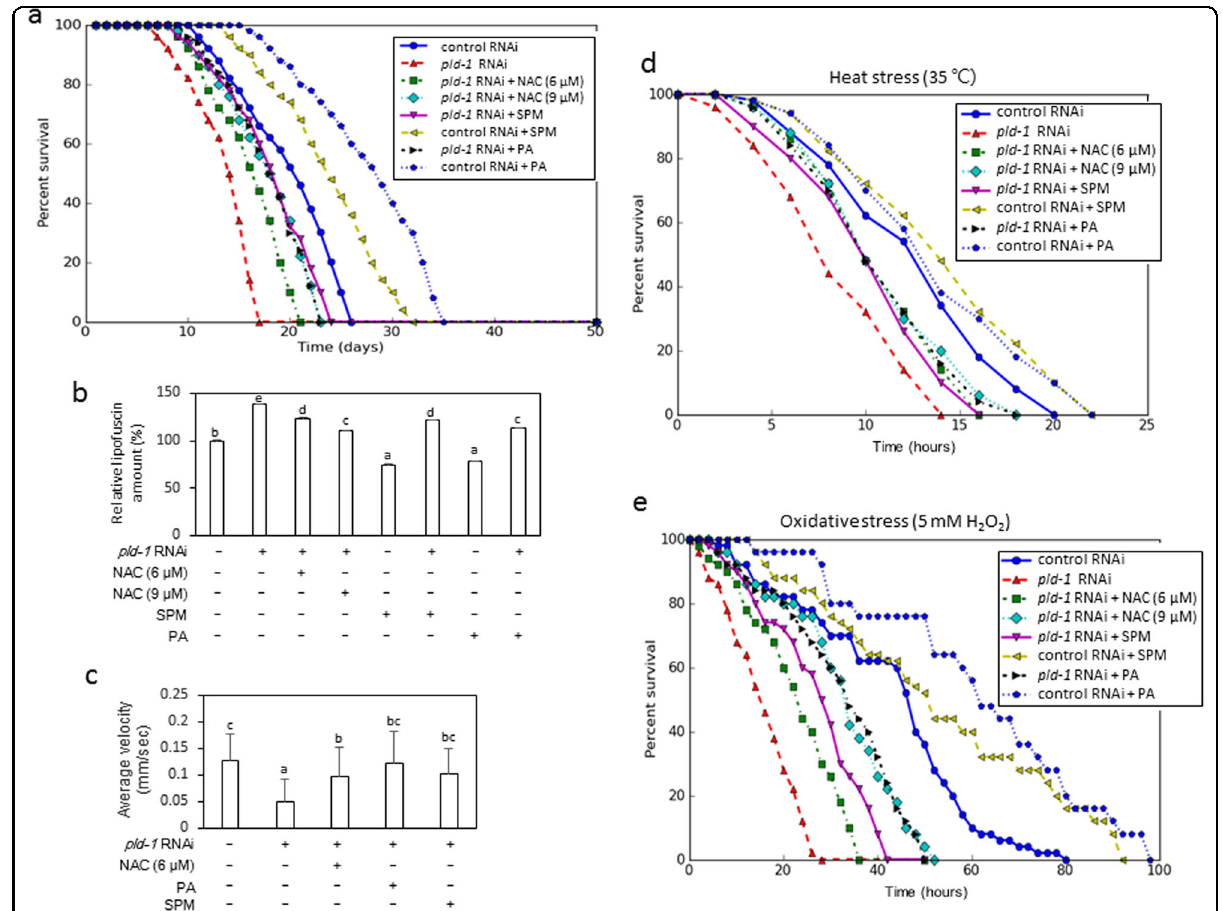
Fig. 4 The ROS scavenger NAC, a putative CK2 activator spermidine, and a PLD effector phosphatidic acid counteract the lifespan shortening and age-related biomarkers induced by pld-1 knockdown. Age-synchronized L4 larvae were fed on control RNAi or pld-1 RNAi